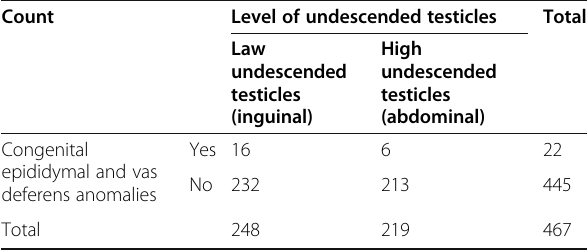
Table 3 Congenital epididymal and vas deferens anomalies with level of undescended testicles